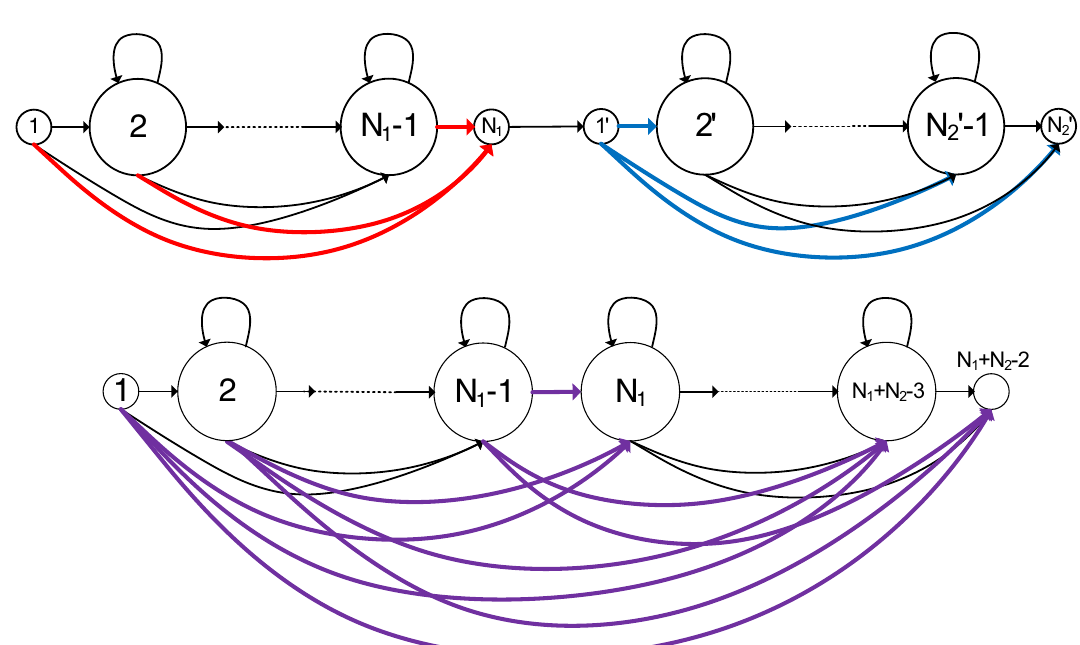
Fig 5. Two HMMs are concatenated to form a combined